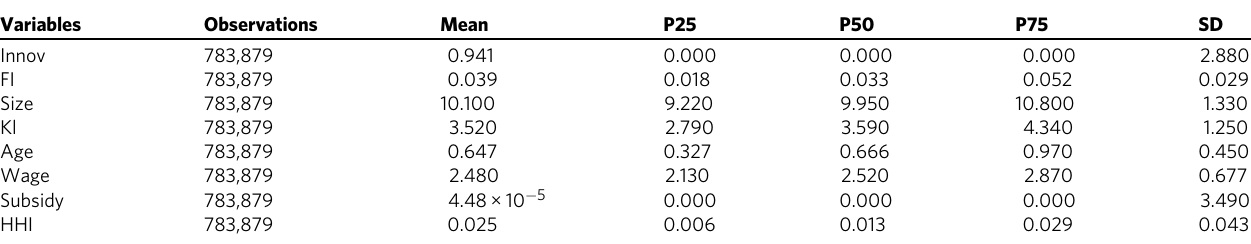
Table 1 Summary